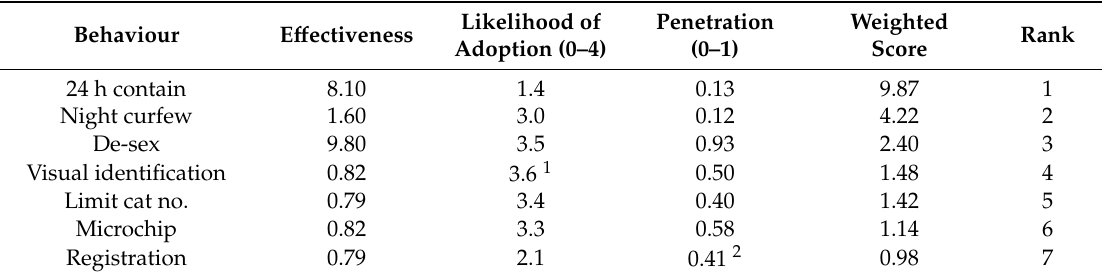
Table 2. Ranking of cat owner behaviours based on e ff ectiveness of behaviour for reducing the number of free-roaming cats, likelihood of adoption by cat owners and current practice (penetration) (after [54]). Data for e ff ectiveness from [56], and survey data for Likelihood and Penetration from Myriad Research [58], except where